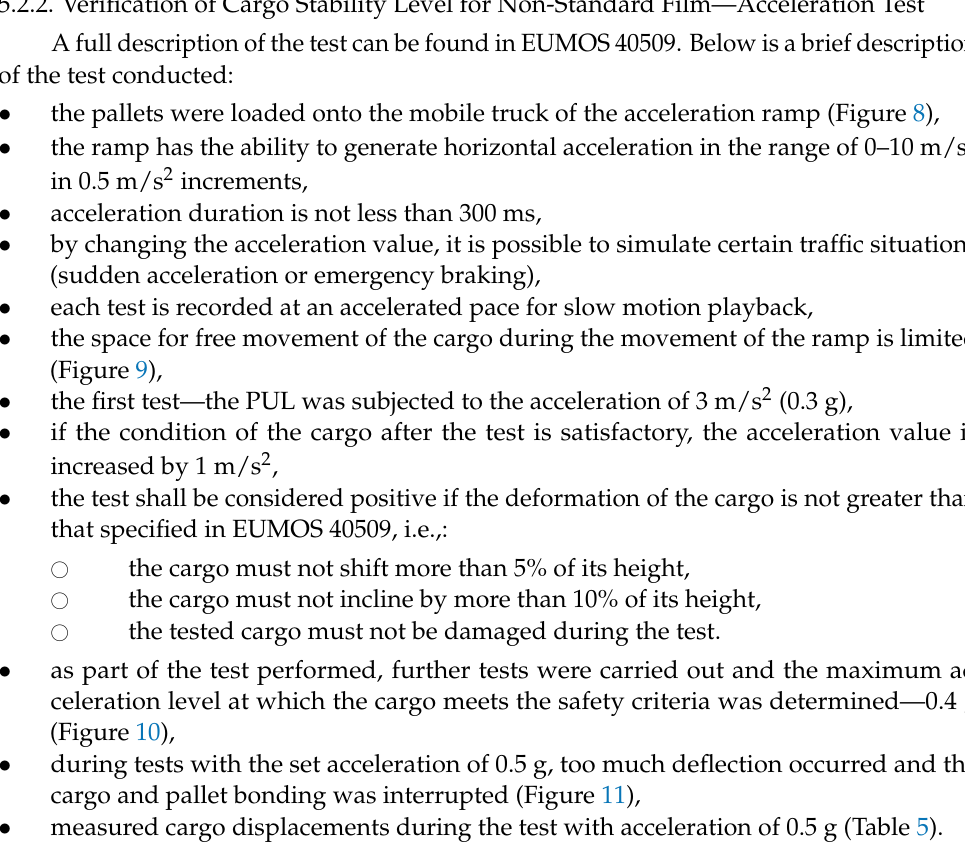
Figure 7. Cargo stabilization forces with the application of the standard film.